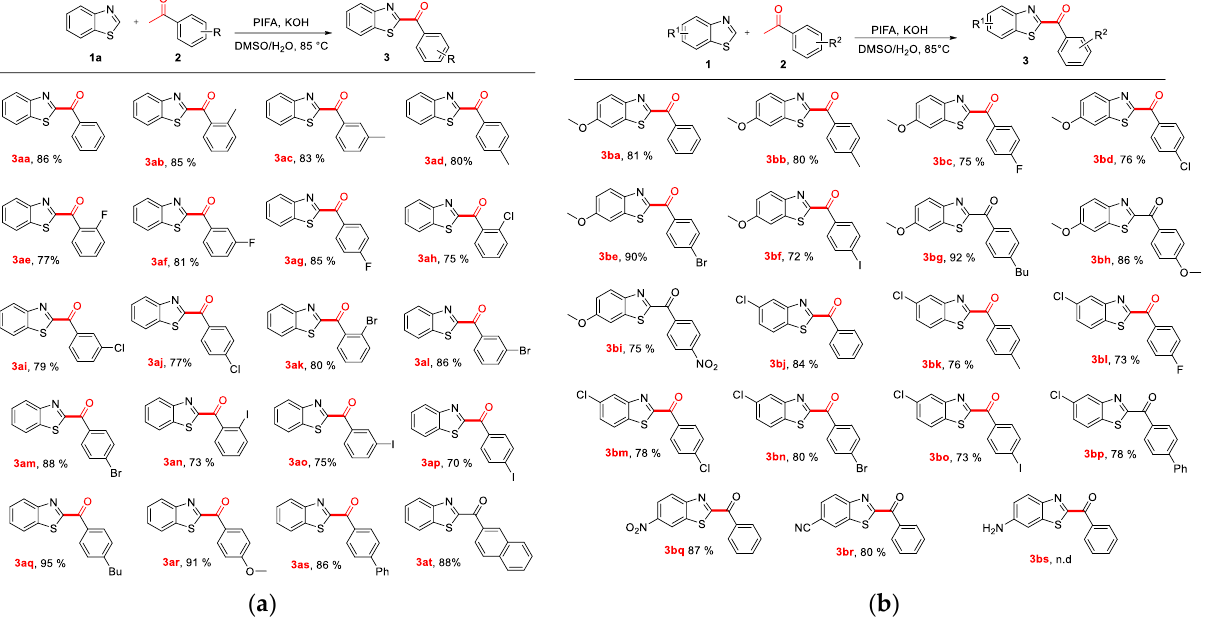
Figure 4. ( a ) Scope of substituted acetophenones. a a Reaction conditions: 1a (1.5 eq., 0.45 mmol), 2 (0.30 mmol), PIFA (2.0 eq., 0.60 mmol), KOH (1.0 eq., 0.30 mmol), DMSO/H 2 O ( v / v , 3/1, 2 mL), 85 °C, 10 h; ( b ) Scope of substituted benzothiazoles and substituted acetophenones. b b Reaction conditions: 1 (1.5 eq., 0.45 mmol), 2 (0.30 mmol), PIFA (2.0 eq., 0.60 mmol), KOH (1.0eq., 0.30 mmol), DMSO/H 2 O ( v / v , 3/1, 2 mL), 85 °C, 10 h.